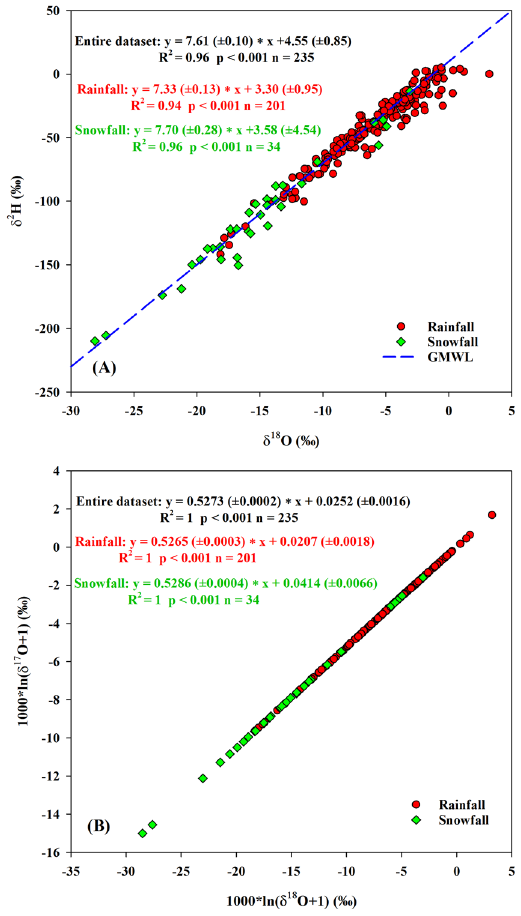
Figure 7. The relationships between δ 18 O and δ 2 H ( A ), δ 18 O and δ 17 O ( B ) in rainfall and snowfall between June 2014 and May 2016.